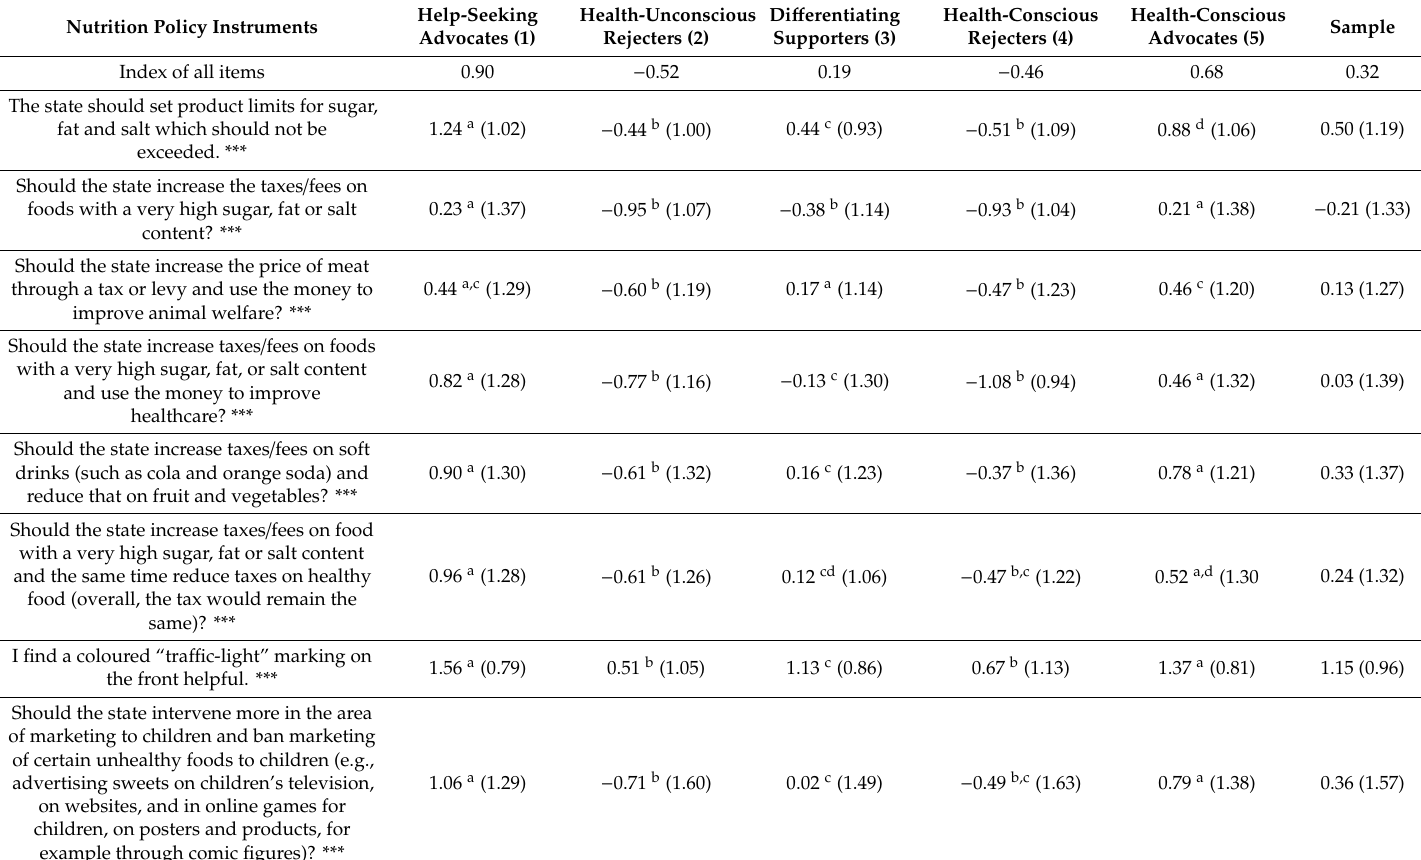
Table 5. Evaluation of specific policy instruments by the five